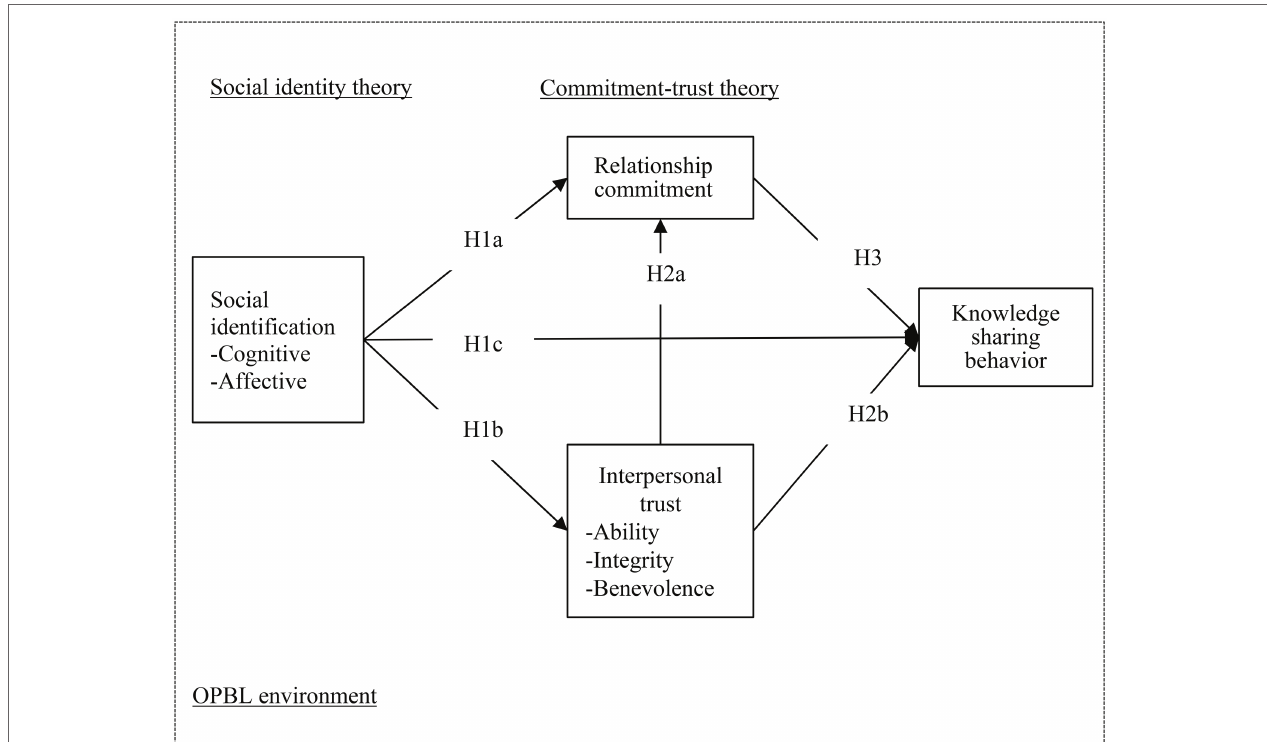
FIGURE 1 | Social identification on KSB in an online problem-based learning (OPBL)